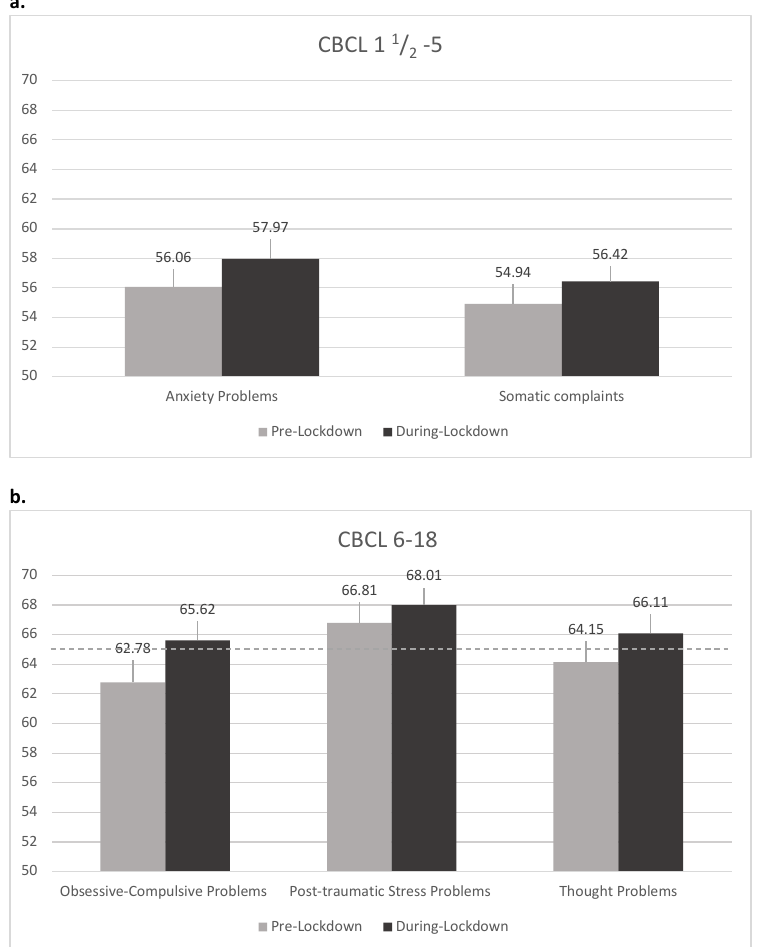
Figure 3. Student’s t–test results: ( a ) CBCL 1.5–5 years subpopulation. Graphical representation of the means in significantly different pre- and during lockdown T-Scores in the CBCL 1.5–5. The segment on top of each bar represents the upper half of the 90% confidence interval, while the dashed line indicates the clinical score for the subscales; ( b ) CBCL 6–18 years subpopulation. Graphical representation of the means in significantly different pre- and during lockdown T-Scores in the CBCL 6–18. The segment on top of each bar represents the upper half of the 90% confidence interval, while the dashed line indicates the clinical score for the subscales.